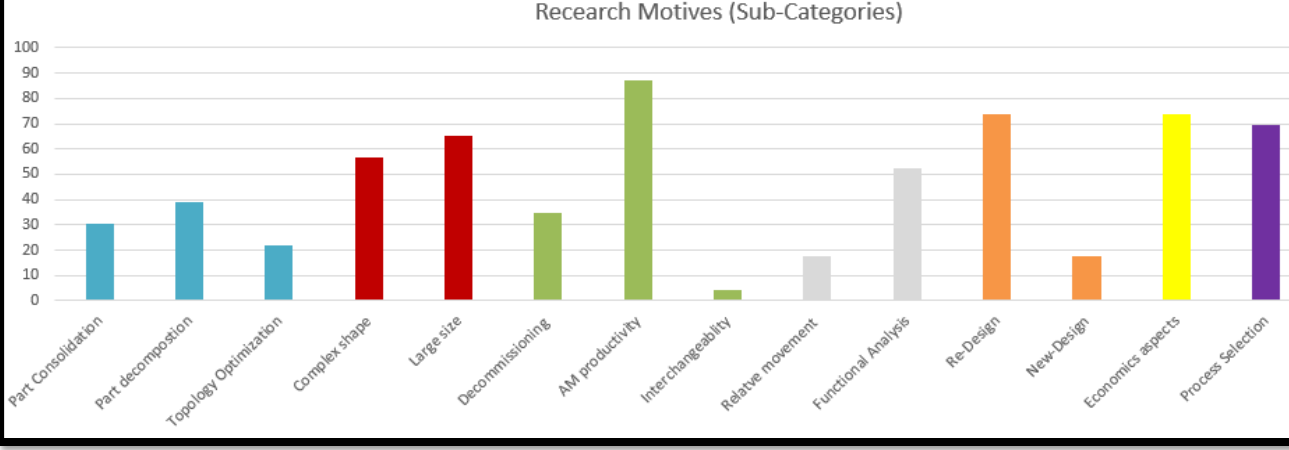
Fig. 6. Research motives